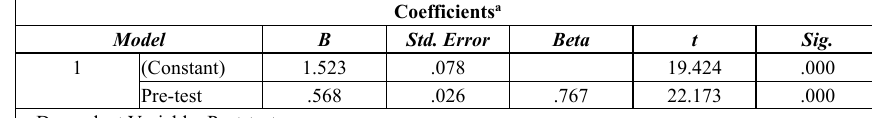
Table 5. Correlation coefficient test result of pre- and post-test scores data